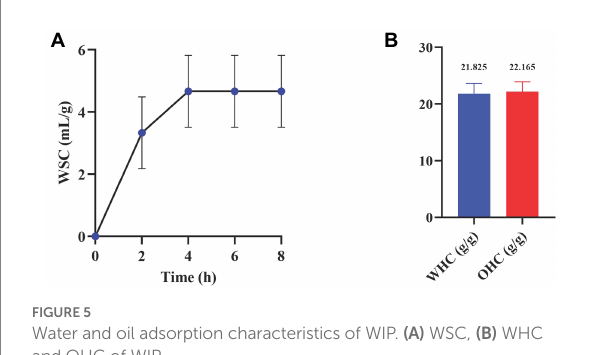
FIGURE 5 Water and oil adsorption characteristics of WIP. (A) WSC, (B) WHC and OHC of WIP.